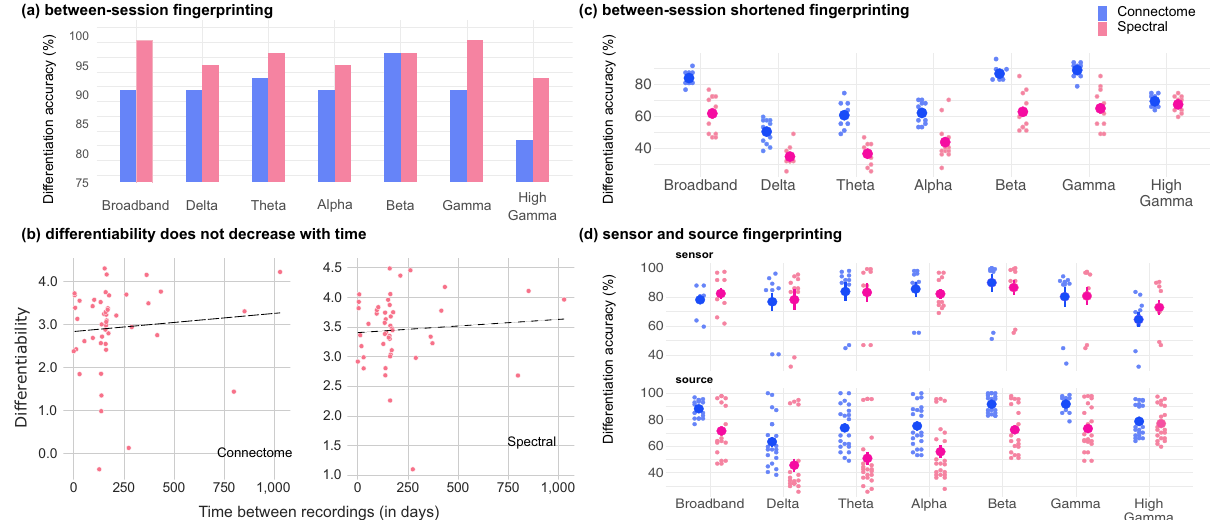
Fig. 3 Between-session fi ngerprinting accuracy. a Differentiation accuracy for connectome and spectral between-session fi ngerprinting. Fingerprinting performances are similar to those from the within-session challenge. b Pearson correlation analyses did not reveal an association between differentiability and the delay between session recordings (connectome fi ngerprinting: r = 0.09, p = 0.5; spectral fi ngerprinting: r = 0.08, p = 0.60). c Between-session- shortened differentiation accuracy using shorter 30 s data segments collected days apart (average: 201.7 days). Each data point represents one combination of datasets used for fi ngerprinting (see “ Methods ” for details). d Scatter plots of all fi ngerprinting challenges across frequency bands for source (brain) and sensor (scalp) level fi ngerprinting (Supplemental Information details the results obtained for all sensor data fi ngerprinting challenges). Source data are provided as a Source Data fi le.